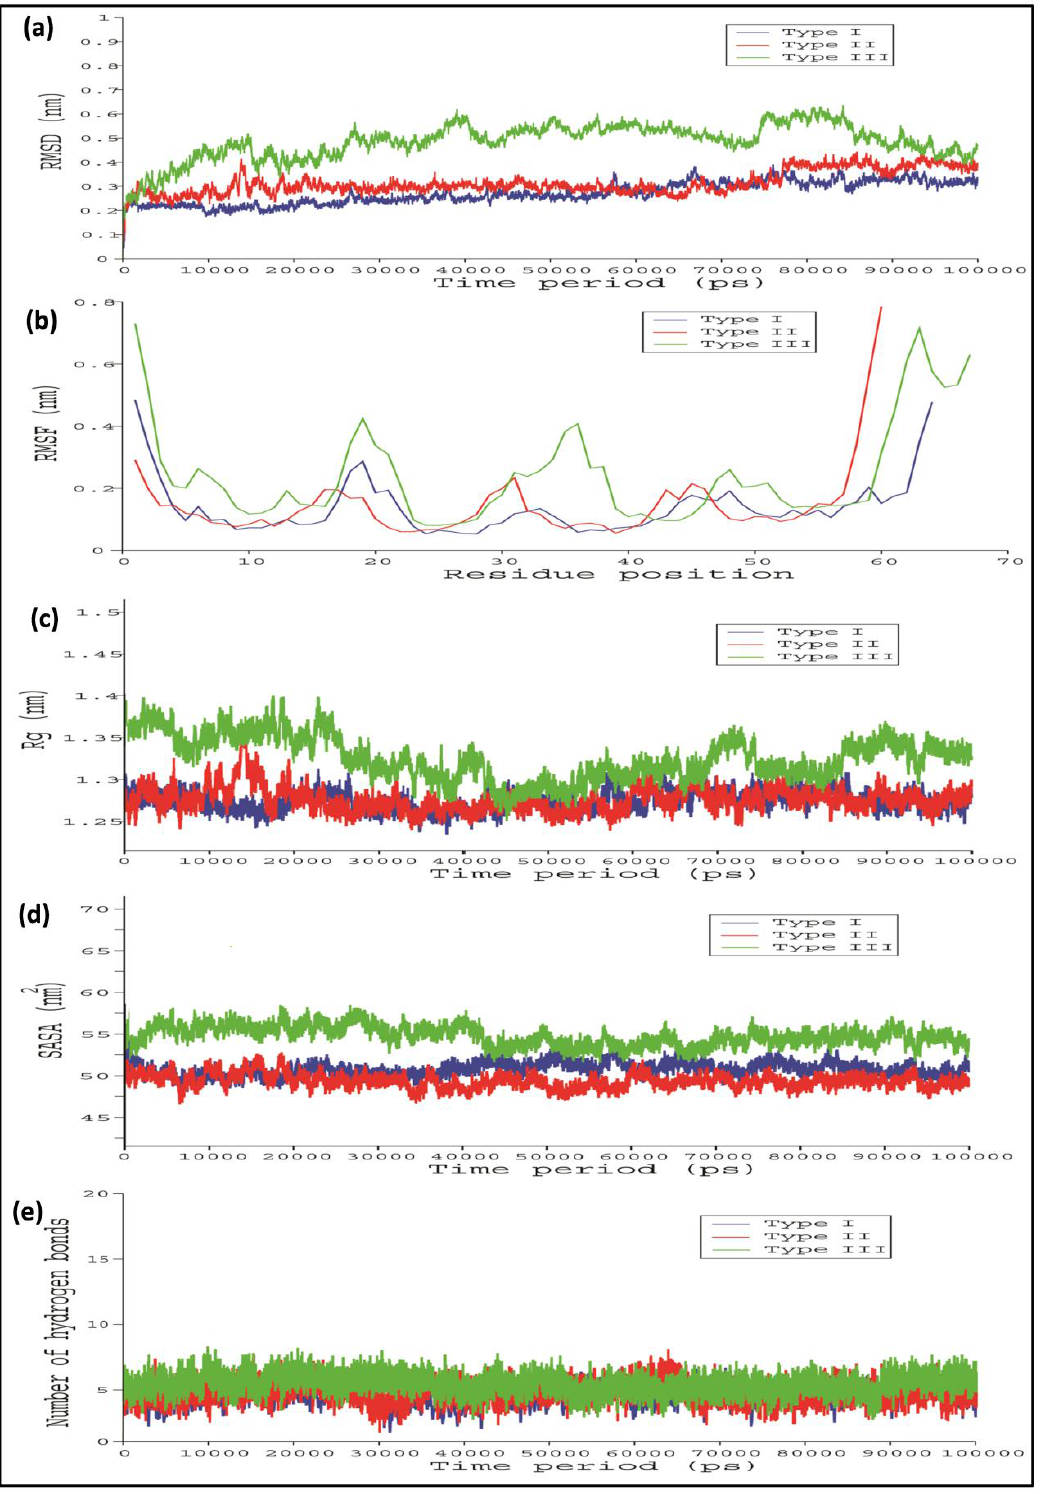
Figure 6. Line graph showing the ( a ) root mean square deviation (RMSD); ( b ) root mean square fluctuation (RMSF); ( c ) radius of gyration (Rg); ( d ) solvent accessible surface area (SASA); and ( e ) number of hydrogen bonds, of Type I, Type II, and III CcWRKY DBD and DNA W-box complexes. (Type I in blue, Type II in red, and Type III in green).